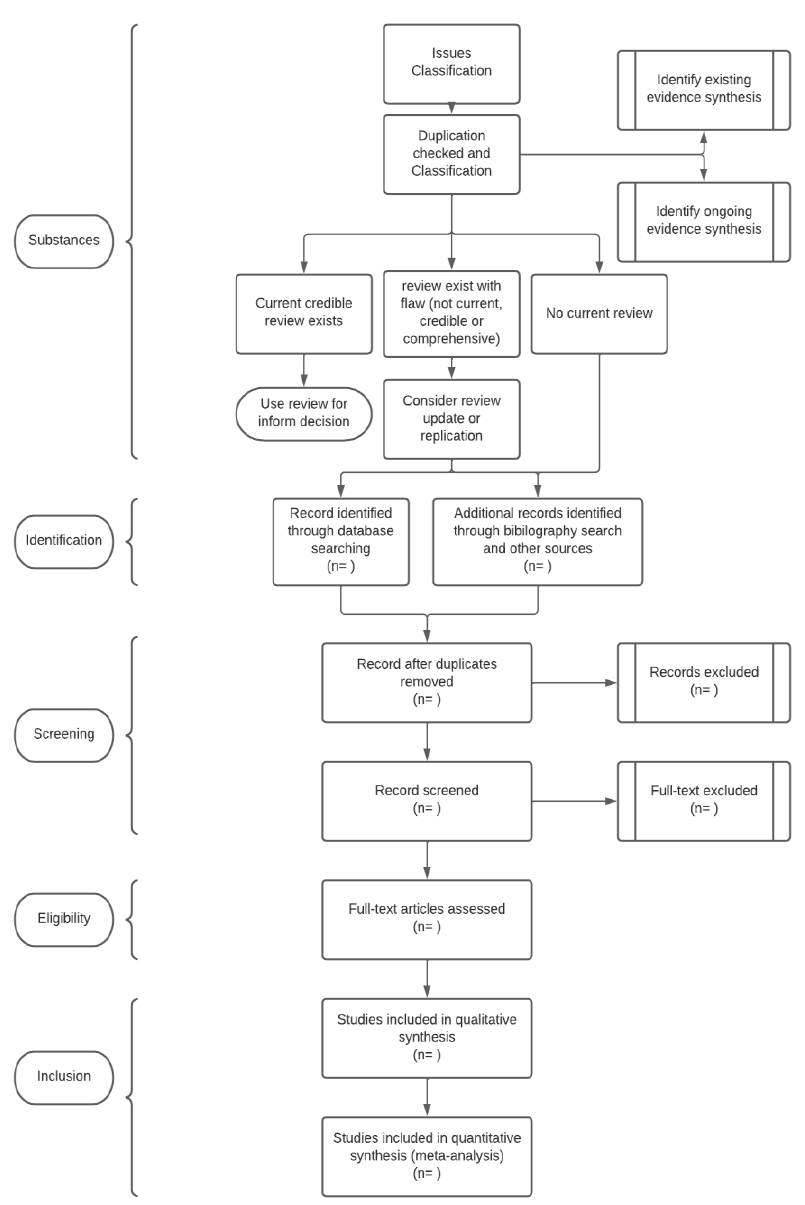
Figure 2. Full flow for search criteria of the systemic review. (Includes database search strategies to include or exclude specific studies from duplicate titles or subjects).